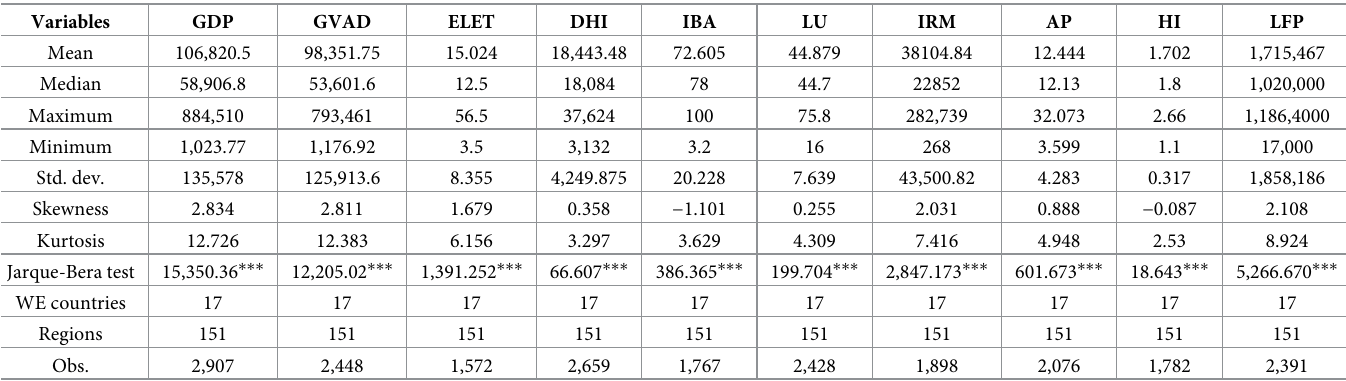
Table 3. Descriptive statistics for Western Europe regions.